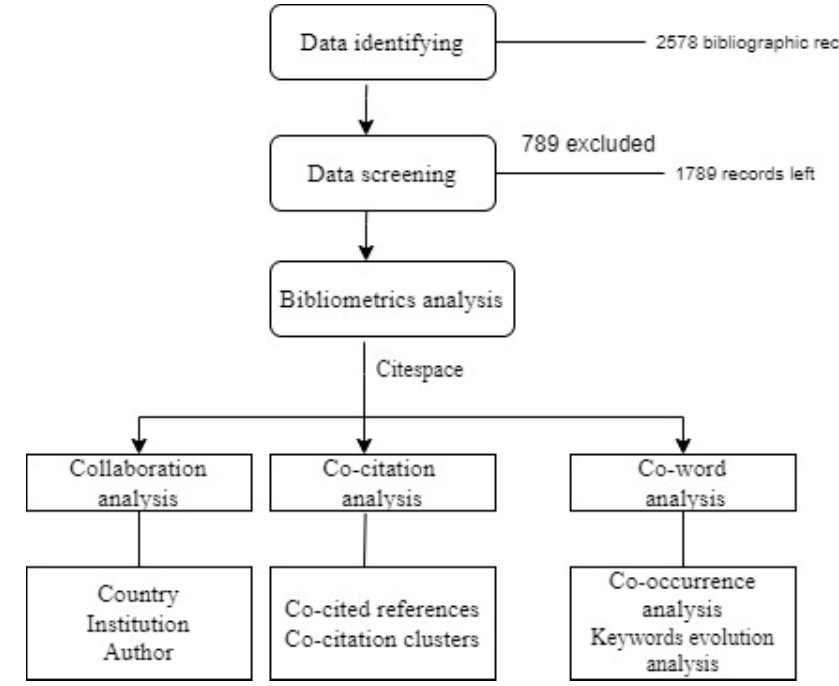
Figure 2. Research